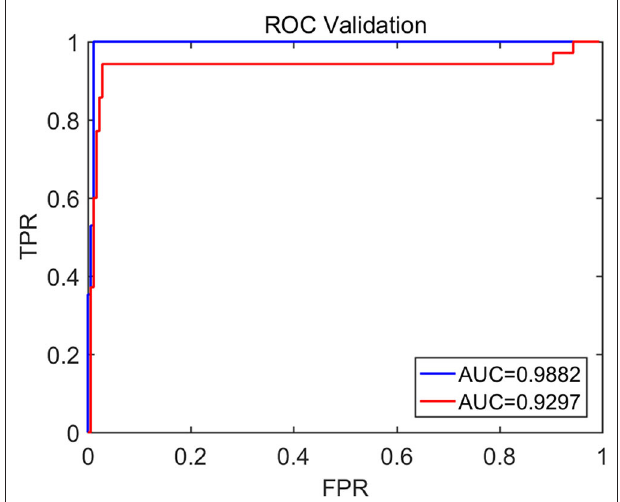
FIGURE 6 | The ROC curve for the testing data. The red and blue curves show respectively the ROC based on methods using Signal Range and H and networks built on Signal Range, energy of the alpha wave component, and H . The AUC for the blue and red curves is 0.9882 and 0.9297, respectively.